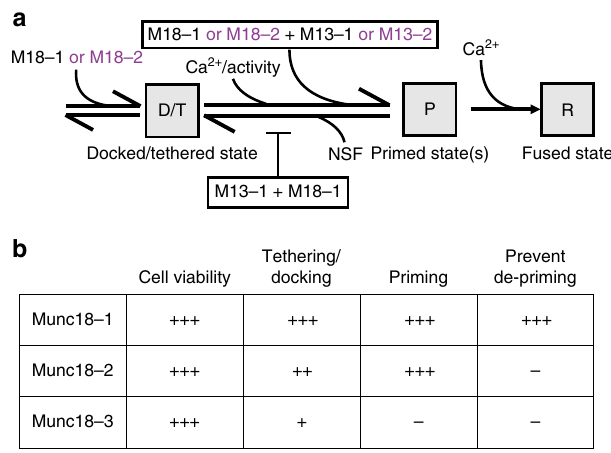
Figure 6 | Working model for how Munc13-1 and Munc18-1 prevent NSF-dependent de-priming and comparison of the function of Munc13/18 isoforms in the secretory pathway ( a ) Flow chart working model of the proposed actions of Munc13, Munc18 in the secretory pathway. Dominant isoforms are depicted in black and non-dominant/heterologous isoforms in purple. ( b ) Summary of proposed (non-) redundancy of cellular functions among Munc18 isoforms 1, 2 and 3 on cell viability, vesicle tethering/ docking, priming, prevent de-priming. Number of þ indicates to what extent a given isoform supports a given function, where þþþ is full support and (cid:2) indicates no